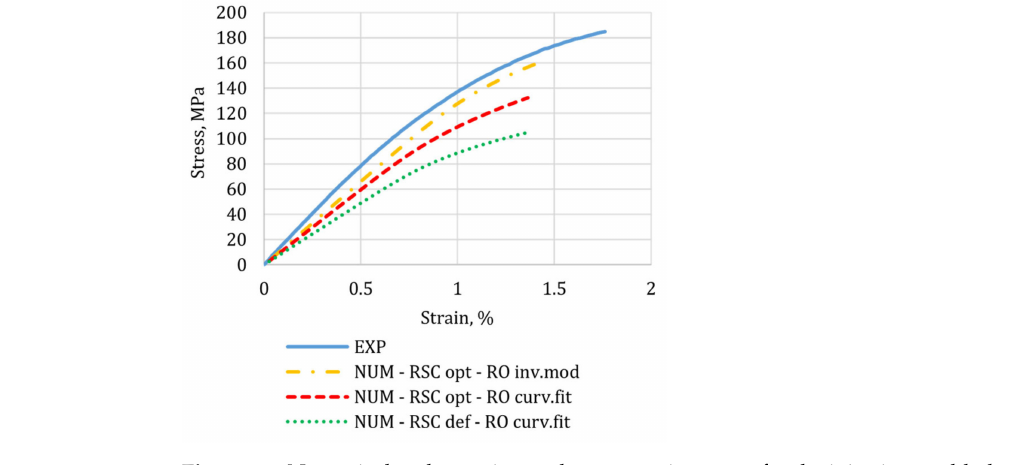
Figure 12. Numerical and experimental stress-strain curves for the injection-molded tensile specimen. Table 1. Measured and predicted mechanical